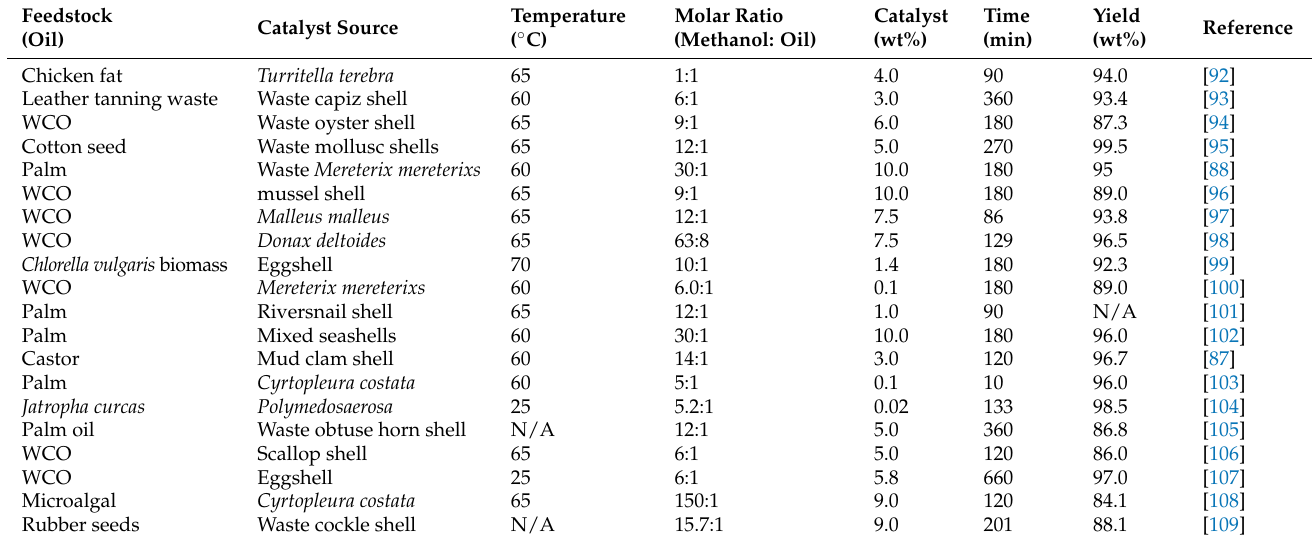
Table 5. Synthesis of seashell-derived CaO from various sources and the reaction conditions in biodiesel production. Feedstock Catalyst (Oil)